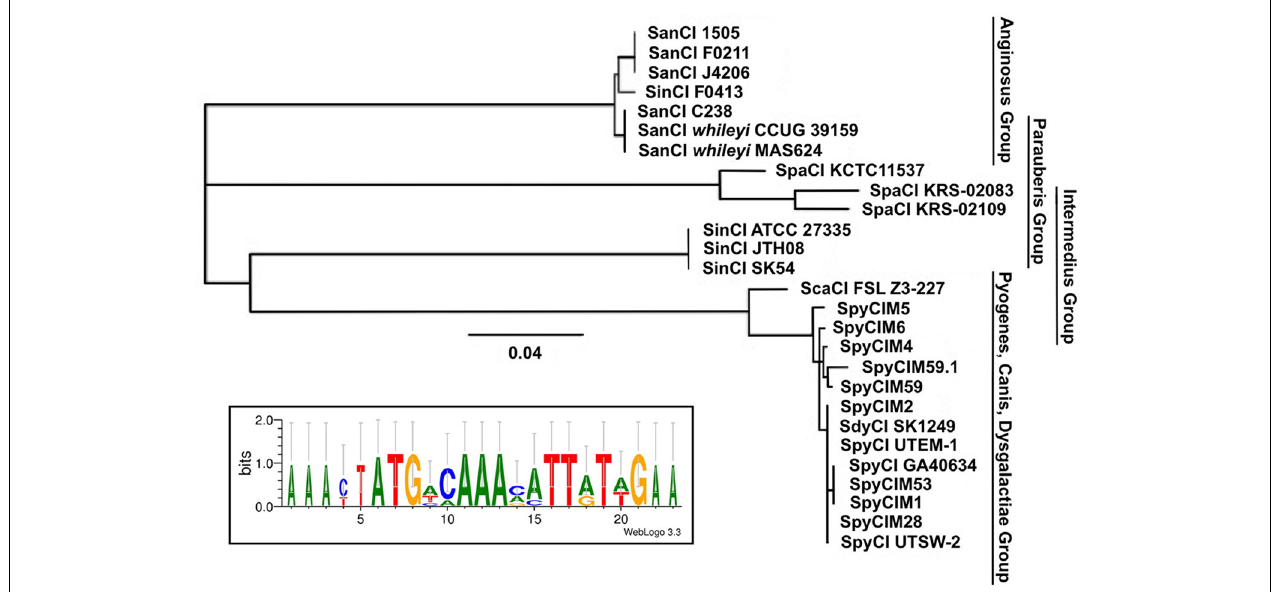
FIGURE 3 | Phylogenetic tree of the streptococcal CI integrases that target MMR gene mutL . Analysis of the chromosomal island integrases amino acid sequences that target mutL was used to construct a phylogenetic tree showing the four known major groups. The insert shows the consensus